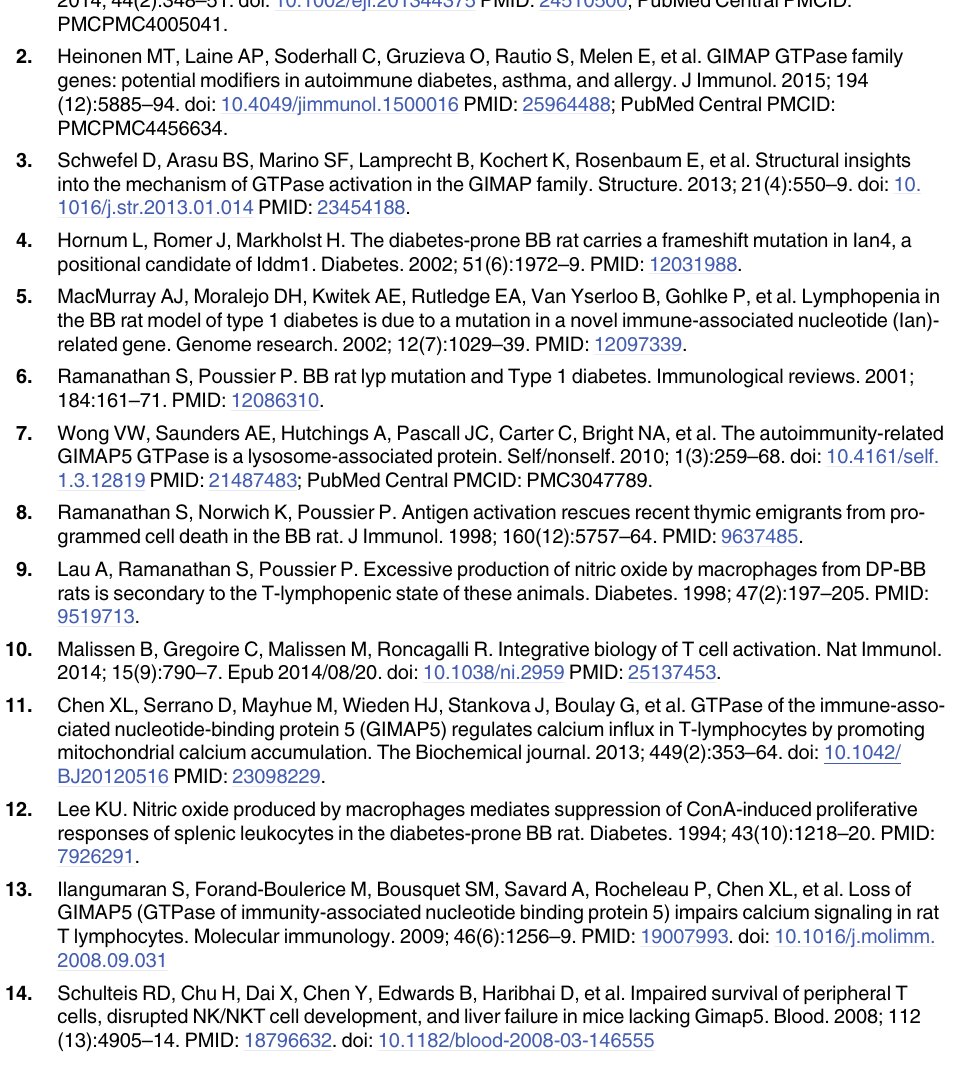
S1 Table. List of antibodies used in this